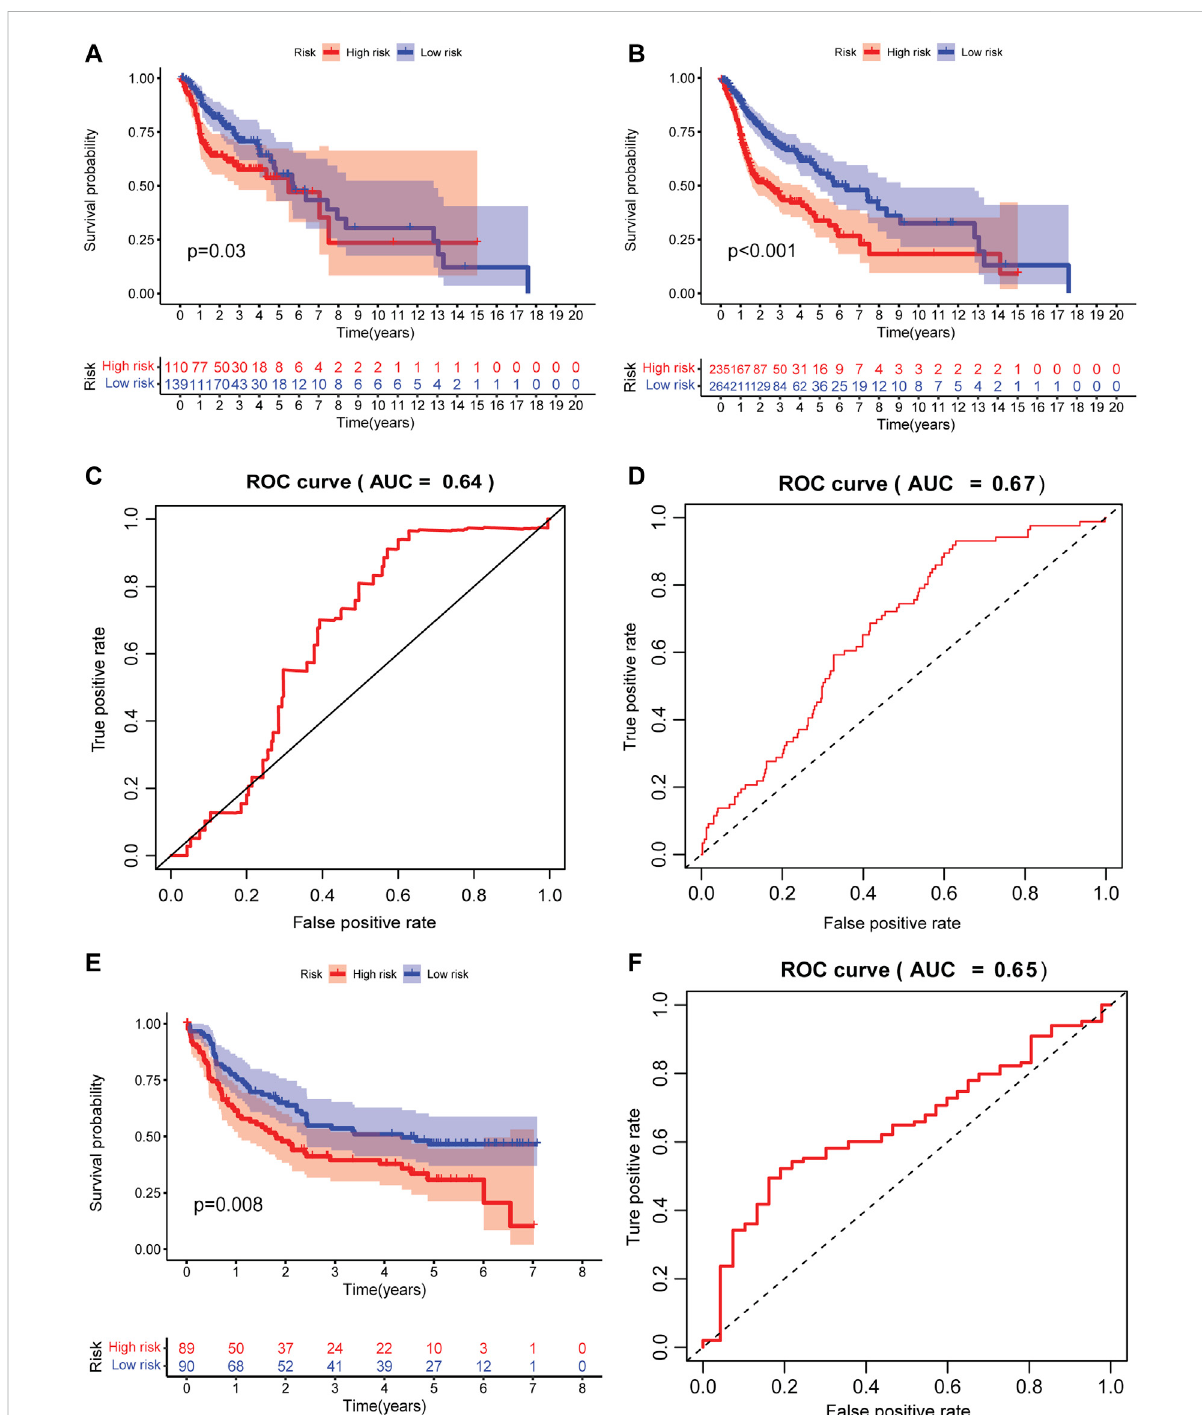
FIGURE 3 Internal and external validation of the prognostic signature. (A) The Kaplan – Meier curve of patients in high- and low-risk groups in the internal validationset. (B) TheKaplan – Meiercurveofpatientsinhigh-andlow-riskgroupsintheentireHNSCCvalidationset. (C) Time-independentreceiver operatingcharacteristiccurveofthesignatureintheinternalvalidationsetcalculatedbytheareaunderthecurve. (D) Thetime-independentreceiver operating characteristic curve of the signature in the entire HNSCC validation set is calculated by the area under a curve. (E) The Kaplan – Meier curve of patients in high- and low-risk groups in the external HNSCC validation set (GSE41613 and GSE42743). (F) The time-independent receiver operating characteristic curve of the signature in the external HNSCC validation set (GSE41613 and GSE42743) is calculated by the area under the